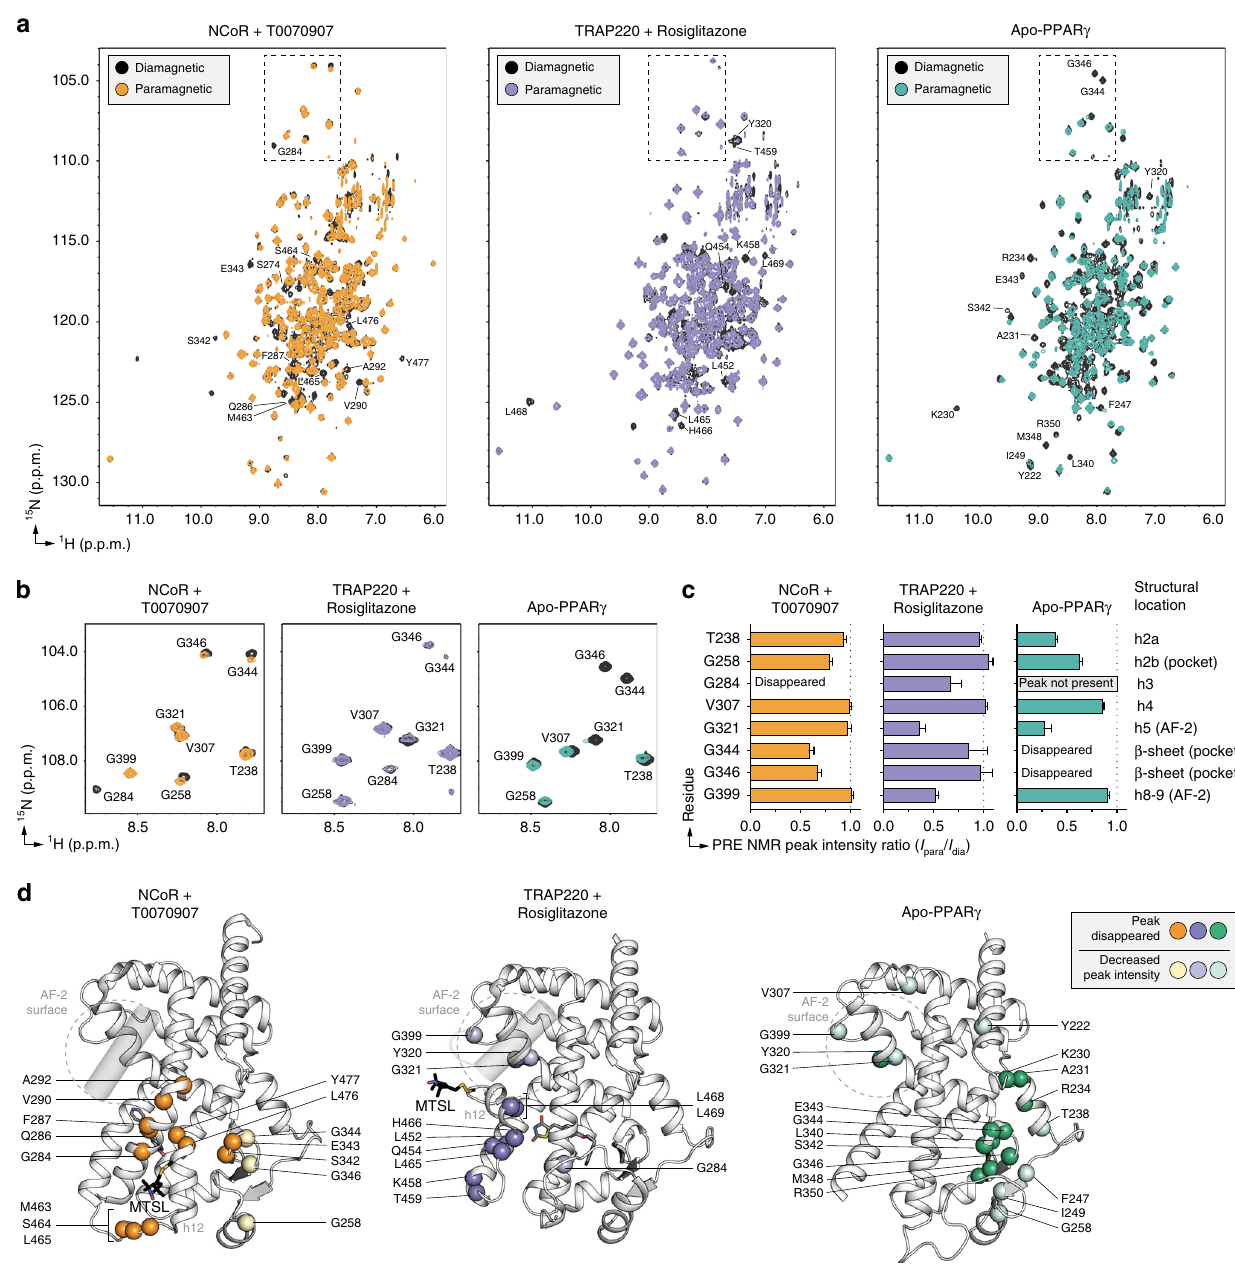
Fig. 7 PRE NMR of the repressive, active, and apo-helix 12 conformations. a Full 2D [ 1 H, 15 N]-TROSY-HSQC spectra from the PRE analysis (see manuscript text and methods for sample descriptions). b , c PRE NMR data from ( b ) a well-dispersed up fi eld 15 N region was used for ( c ) quantitative peak intensity analysis (error bars calculated using s,d. of data noise levels). d Structural mapping of PRE NMR data to the repressive (NCoR + T0070907; PDB 6ONI), active (TRAP220 + rosiglitazone; PDB 6ONJ), and apo (PDB 1PRG, chain A; helix 12, residues 460 – 477, is not shown as this conformation is not consistent with the PRE NMR data) conformation PPAR γ LBD crystal structures. Source data are provided as a Source Data fi SR11023 (antagonist), and GW9662 (covalent antagonist). An K265 (Supplementary Fig. 12a) and K474-K275 (Supplementary NCoR ID2 peptide-dependent increase in BS3 crosslink enrich- Fig. 12b) crosslinks. However, at that time it was not apparent that ment was detected between K474 on helix 12 with two residues in helix 12 could adopt a corepressor-bound conformation within the Ω -loop (K265 and K275). No NCoR ID2 peptide-dependent the orthosteric pocket. The K474-K265 XL-MS modeled helix 12 BS3 crosslinks were detected between K474 and a residue located conformation is similar to two recent crystal structures of PPAR γ in the AF-2 surface, K301 on helix 3, which were detected for apo- LBD bound to two chemically related antagonist and inverse PPAR γ and SRC-1 ID2 peptide-bound forms. We previously used agonist ligands, SR11023 and SR10171, respectively, without this XL-MS data to model the agonist and antagonist conforma- coregulator peptide 31 . These structures also show surface exposed helix 12 conformations that wrap around helix 3 but in a different tional landscape of helix 12, which included two modeled orientation (Supplementary Fig. 12c, d), a conformation that may corepressor-bound conformations where helix 12 is surface be in fl uenced by crystal contacts (Supplementary Fig. 8c). exposed and partially wraps around helix 3 based on the K474-